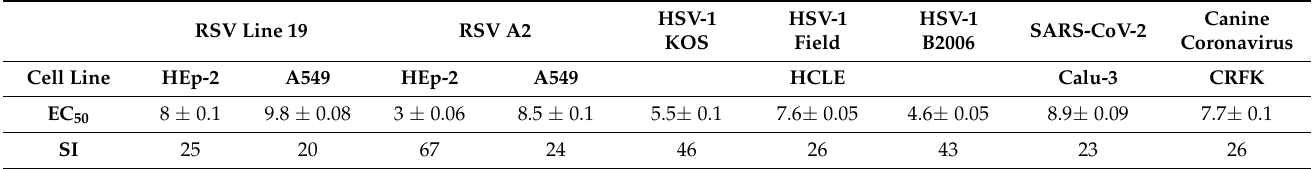
Table 1. EC 50 and SI of